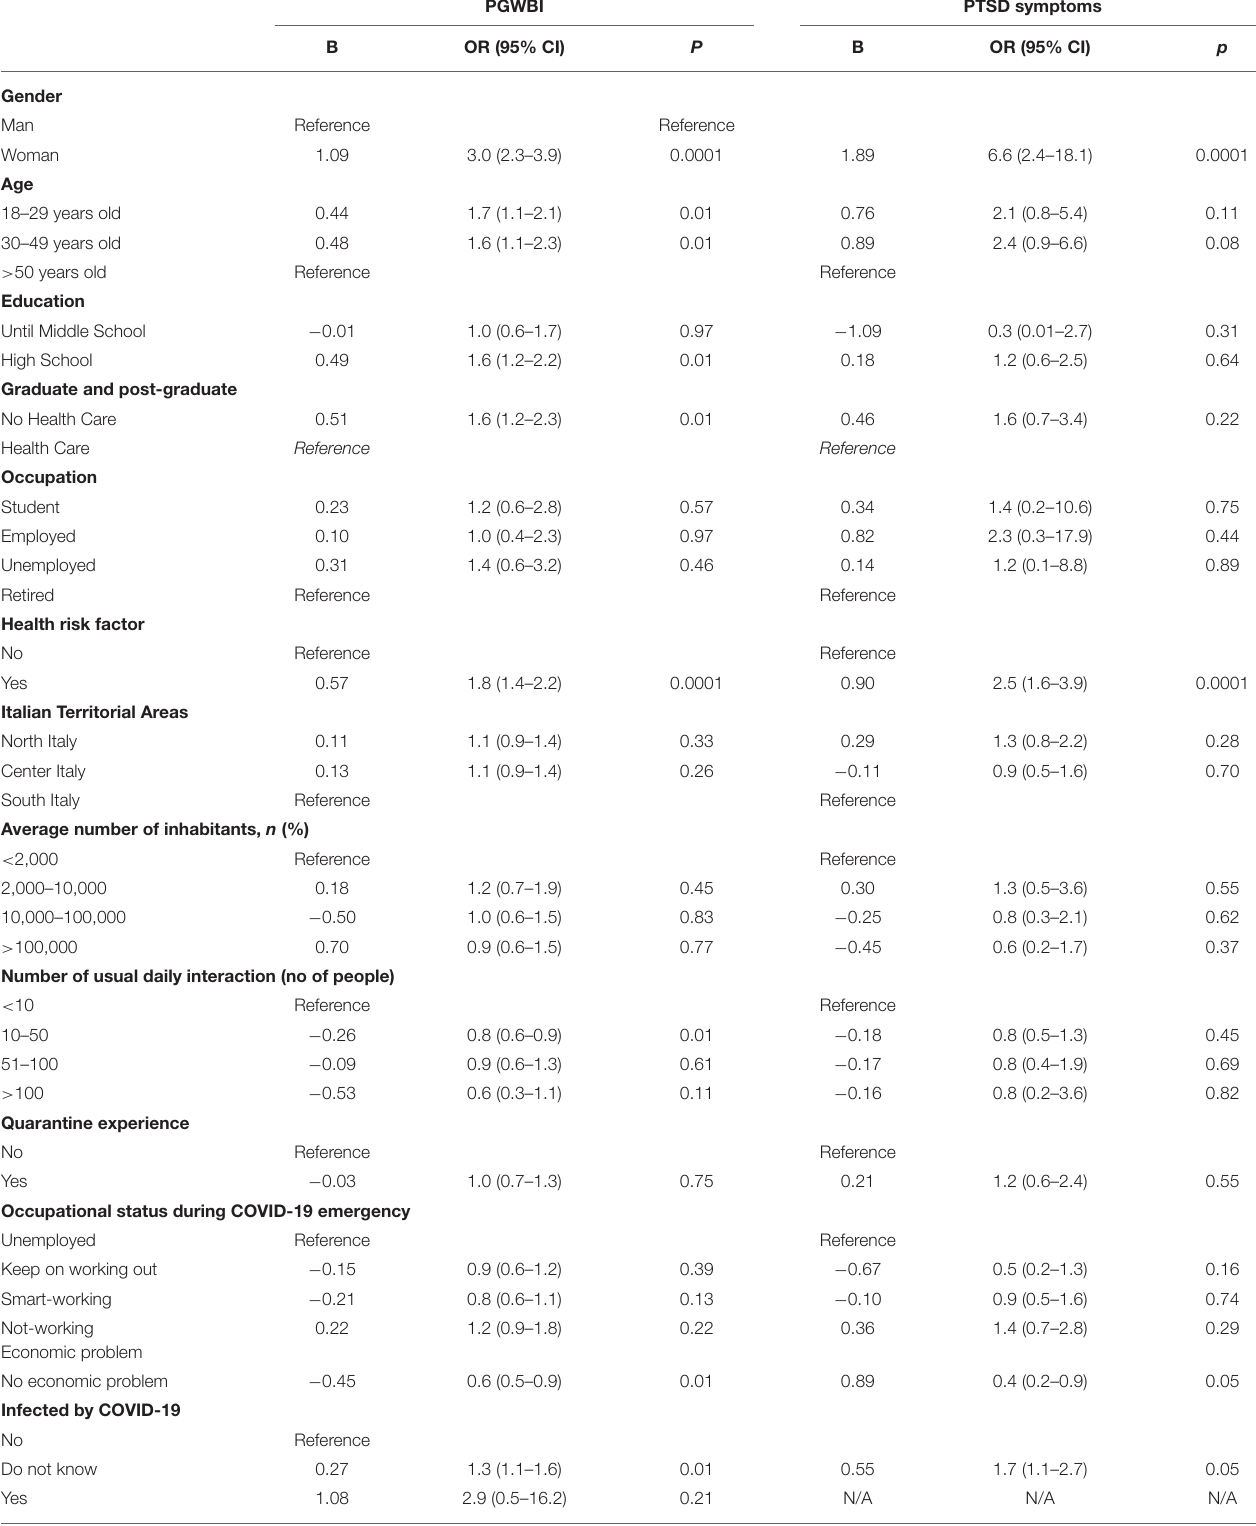
TABLE 7 | Results of the logistic